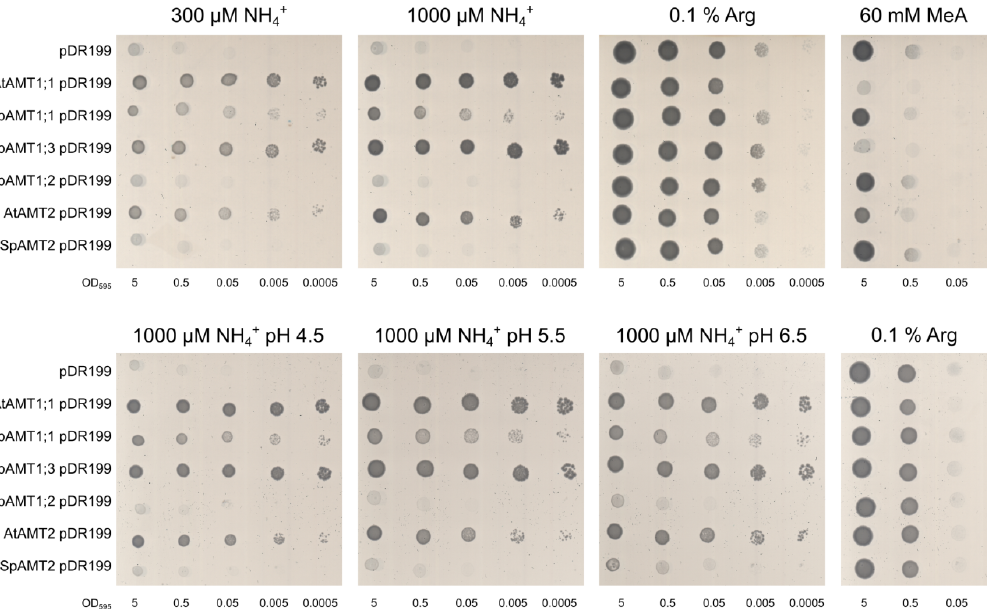
Figure 3. Transport activity of SpAMTs in yeast. Top panel represents growth on 0.3 or 1 mM NH 4 Cl as sole nitrogen source, 0.1 % ( w / v ) Arginine was used as a positive control. Growth on 60 mM MeA was used as a toxicity test, with 0.1 % ( w / v ) Arginine as nitrogen source. The bottom panel shows growth on 1 mM NH4Cl when media was buffered at pH 4.5, 5.5 or 6.5 unbuffered media with 0.1 % ( w / v ) Arginine was used as dilution control. Spotted were five 10 times dilutions starting with OD 595 = 5. Pictures are representatives of four independent repetitions.